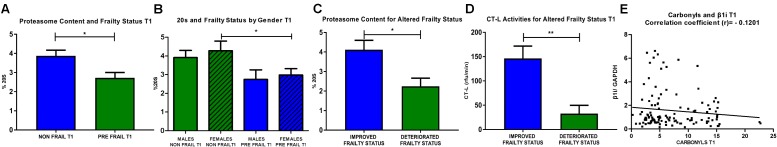
(A) 20S proteasome levels after the intervention were analyzed in sub-clusters of non-frail and pre-frail subjects (unpaired t-test, Mean ± SEM). (B) 20S proteasome levels of non-frail and pre-frail subjects were subsequently analyzed for male and female subjects after the intervention (unpaired t-test, Mean ± SEM). (C) 20S proteasome levels were determined in subjects that demonstrate improvement in their frailty status after the intervention (from pre-frail at T0 to non-frail at T1) in comparison with the subgroup of deteriorated frailty status (from non-frail at T0 to pre-frail at T1) (unpaired t-test, Mean ± SEM). (D) Subjects that improved their frailty status were compared with those of the subgroup with deteriorated frailty status, and after intervention, showed significantly increased levels of CT-L activity (unpaired t-test, Mean ± SEM). (E) Analysis of correlation between β1i expression levels and protein carbonyls’ levels after the intervention (paired t-test, number of pairs: 119). ∗p < 0.05 and ∗∗p < 0.01.